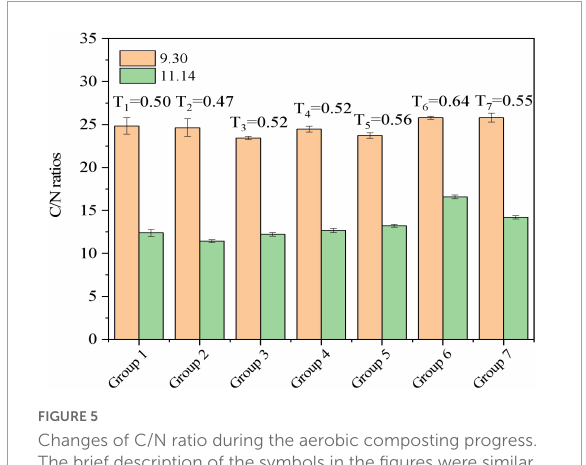
FIGURE5 Changes of C/N ratio during the aerobic composting progress. The brief description of the symbols in the figures were similar with Figure 1